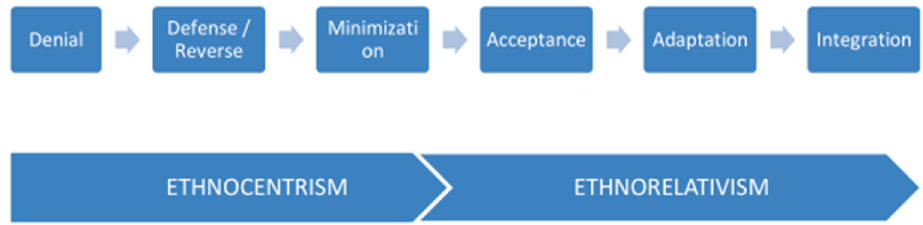
Figure 1. The stage of moving from ethnocentrism to ethnorelativism is based on DMIS